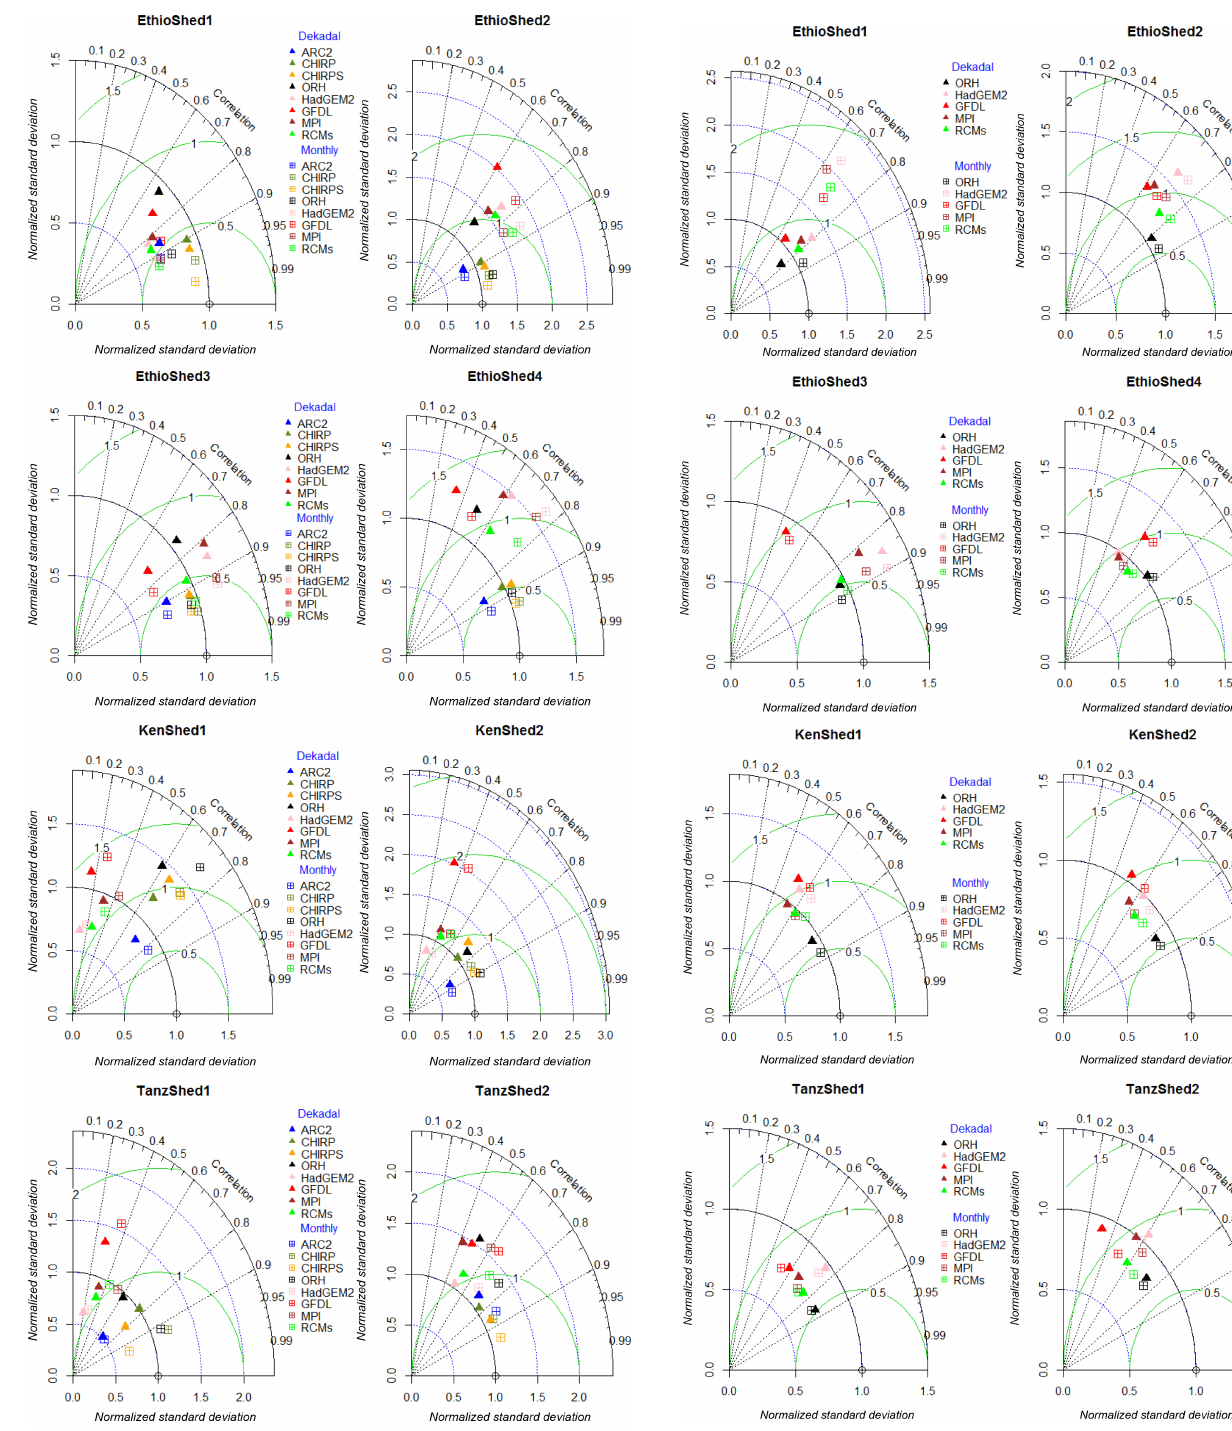
Figure 8. Taylor diagram displaying the agreement between ground observations and synthesized dekadal and monthly rainfall over eight validation areas of Ethiopia, Kenya, and Tanzania covering the period of 1983–2005.